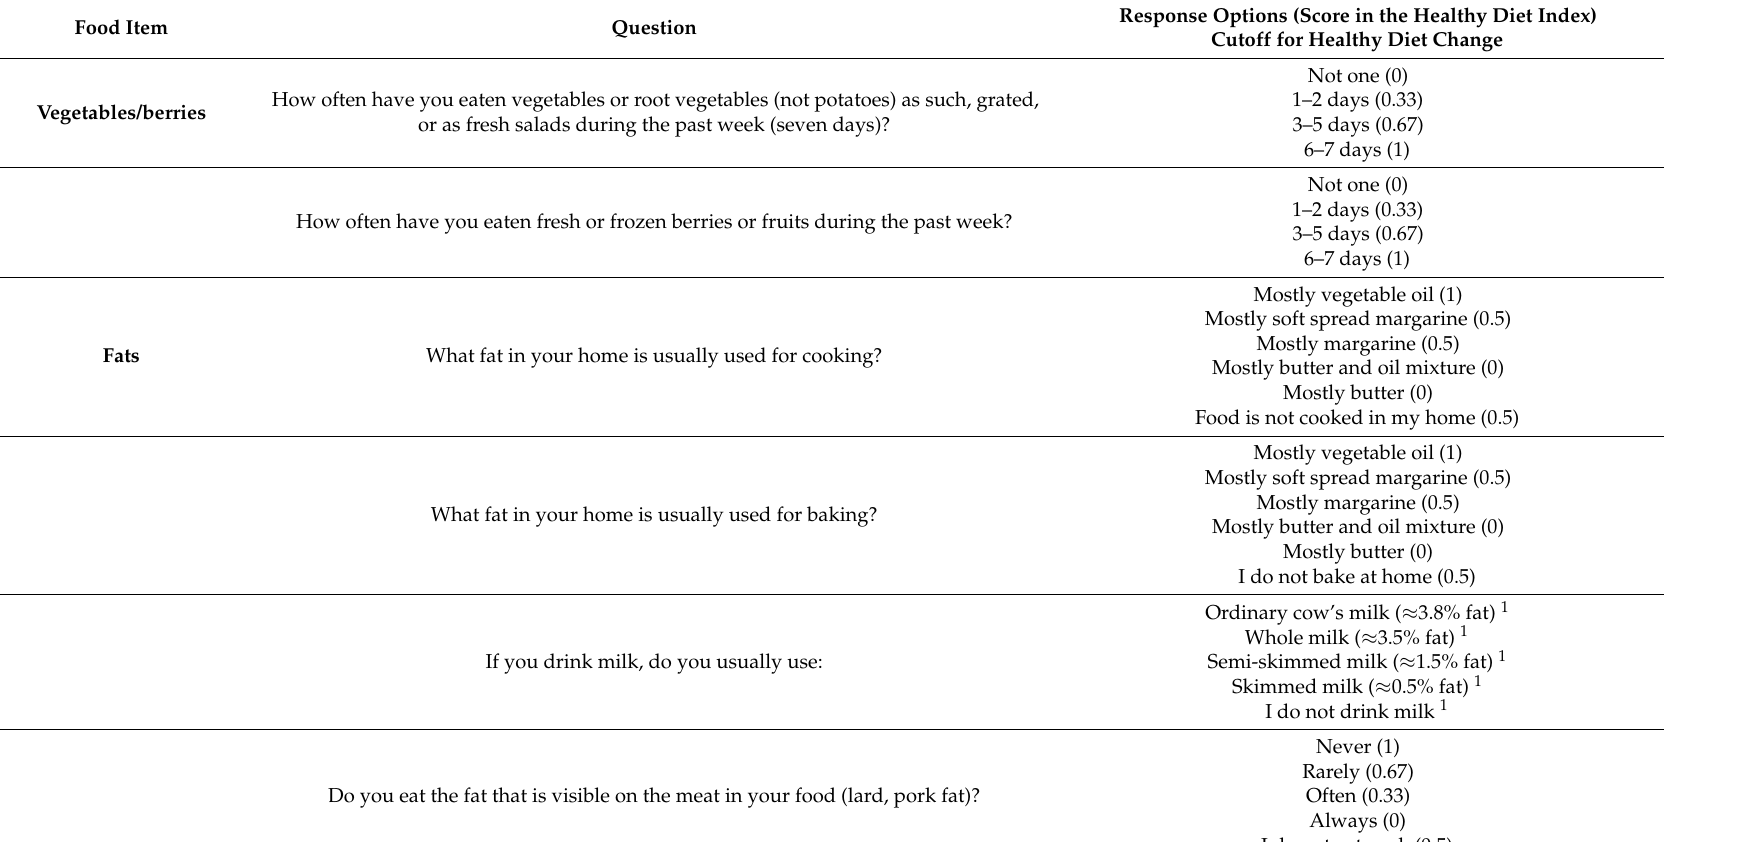
Table 1. Formation of a healthy diet